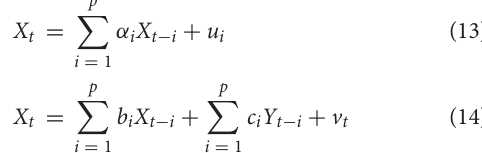
FIGURE 4 | Order identification by the two transfer entropy methods. The dashed line k = 2 corresponds to the lag order when the transfer entropy value is the largest in the linear TE method in Figure 3